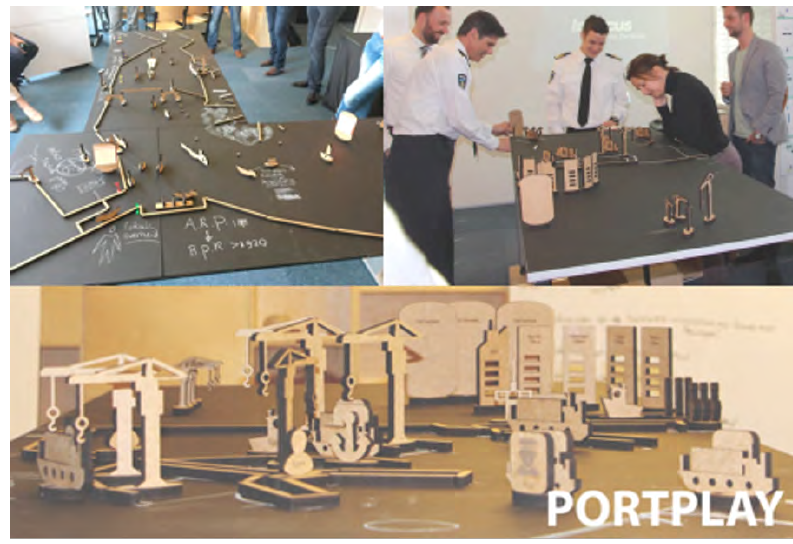
PortPlay innovation tool in use ©Nieuwsma and Mulder,